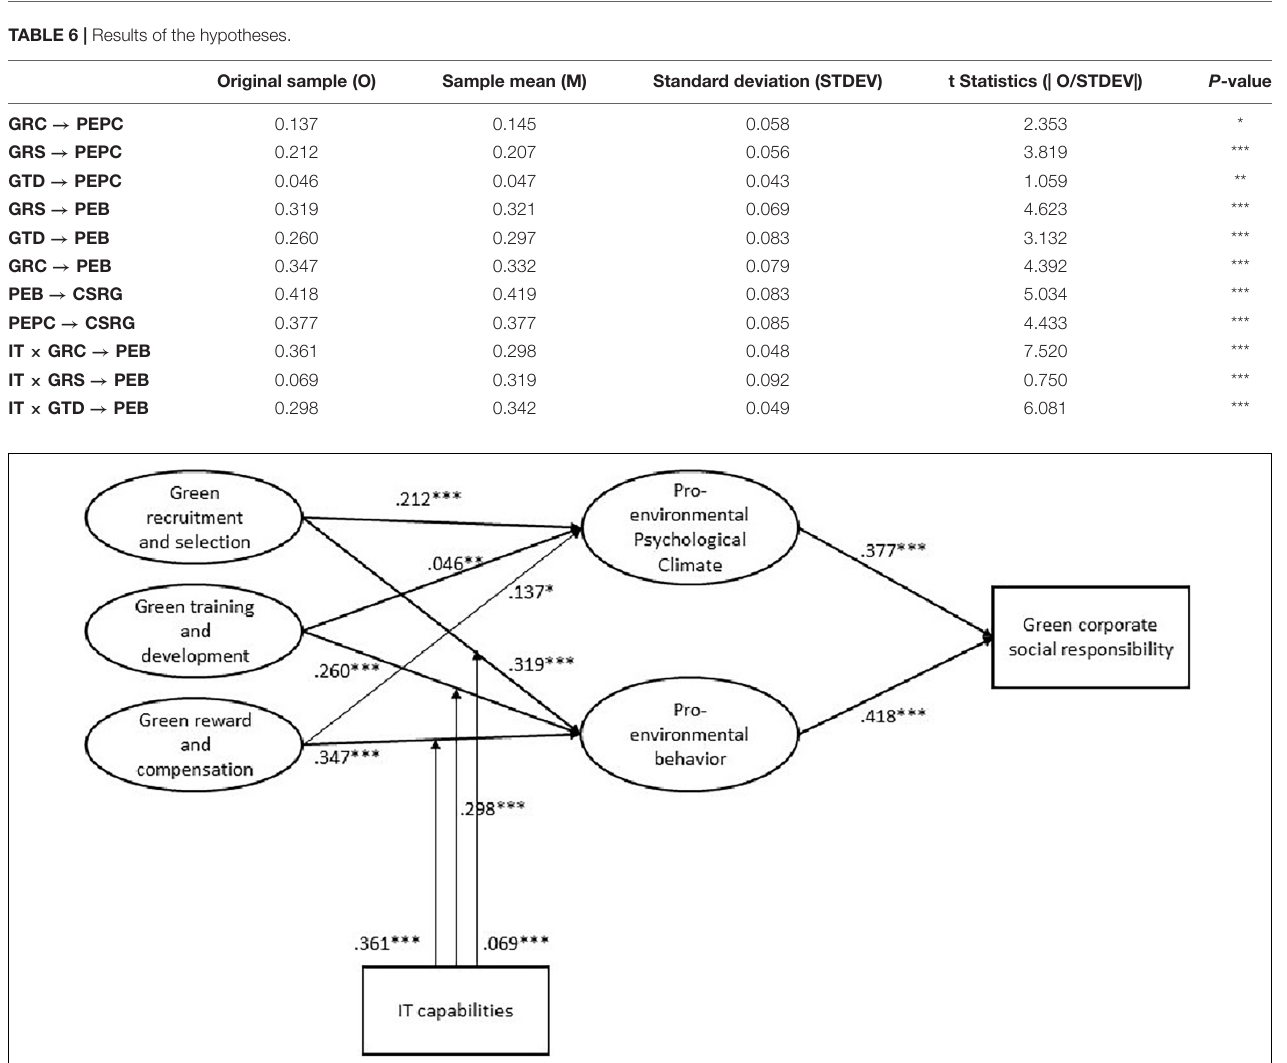
FIGURE 2 | Results of the